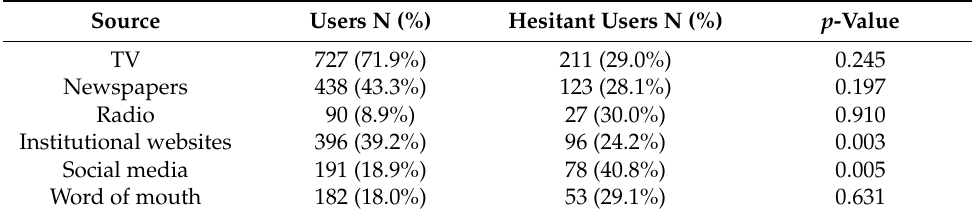
Table 2. Frequency of use of each information source and proportion of hesitant